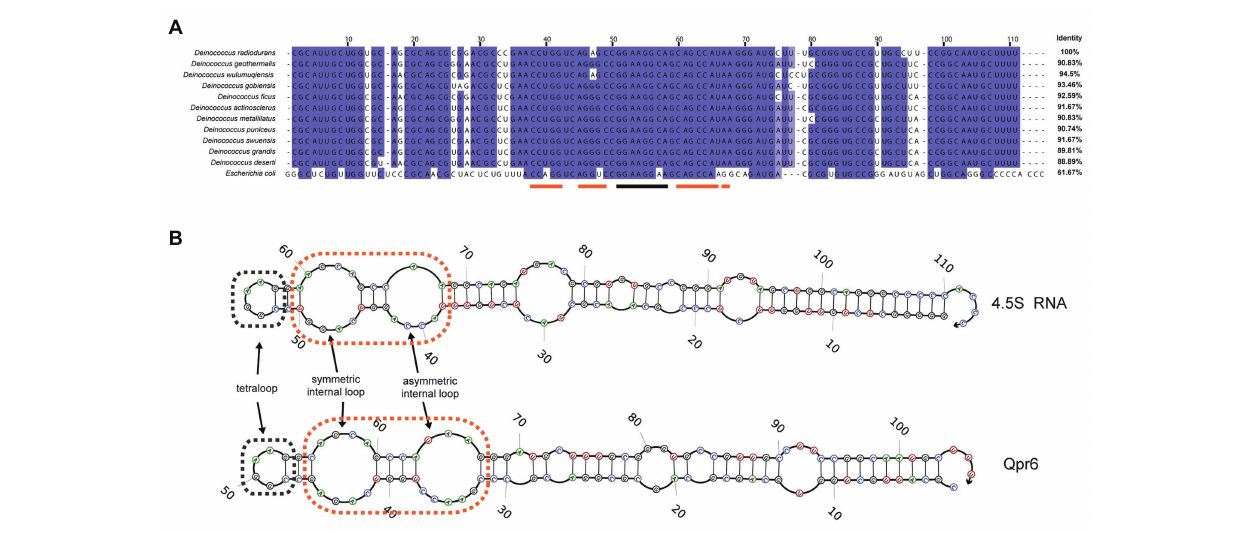
FIGURE 1 | Characterization of Qpr6 as the signal recognition particle (SRP) RNA in Deinococcus radiodurans . (A) Sequence alignment of SRP RNAs from different Deinococcus species and Escherichia coli , with the numbering consistent with the SRP RNA of D. radiodurans R1 (Qpr6). Residues with ≥ 90% conservation indicated are in blue and residues with ≥ 70% conservation are indicated in light blue. The region forming tetraloop on Qpr6 is indicated with black lines, and the regions forming symmetric and asymmetric loops on Qpr6 are indicated with orange lines. (B) Alignment of predicted secondary structure of Qpr6 and 4.5S RNA. The symmetric internal loops and the asymmetric internal loops are highlighted in orange boxes. The tetraloops are highlighted in black